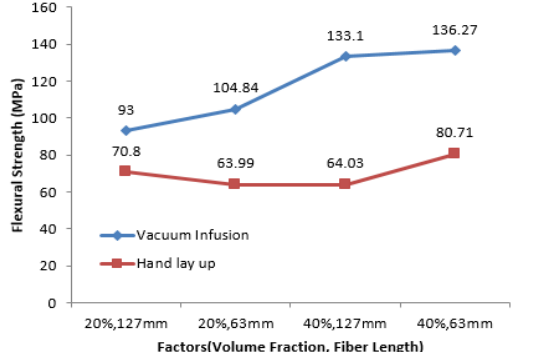
Figure 7: Relationship between specimen with 40% volume fraction offiber and specimen with no-fiber manufacture by vacuum infusion process.